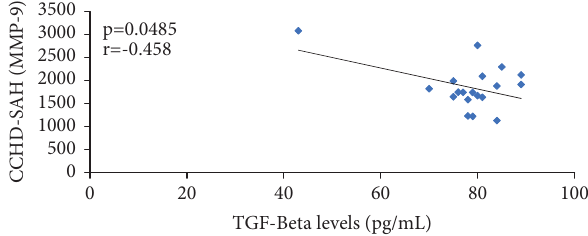
Figure 3: Moderate negative correlation between MMP-9 plasma levels and TGF-beta plasma levels in patients with CCHD-SAH (chronic chagas heart disease-systemic arterial hypertension).